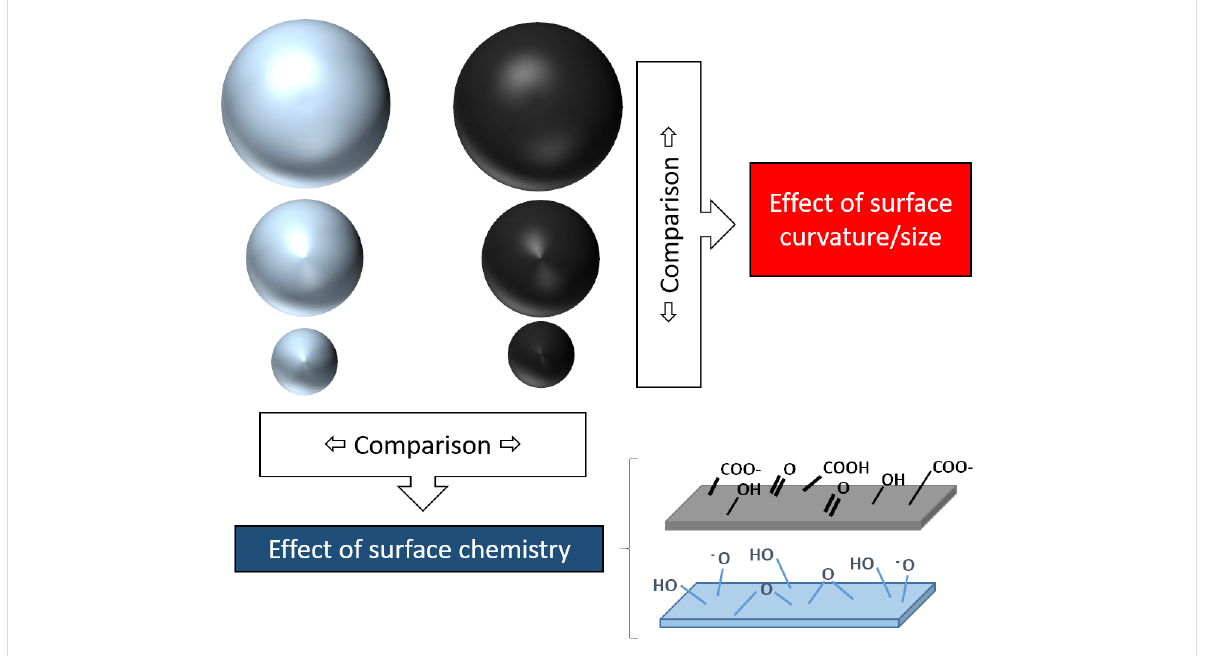
Figure 12: The strategy used to unravel possible structure–activity relationships in the present study.